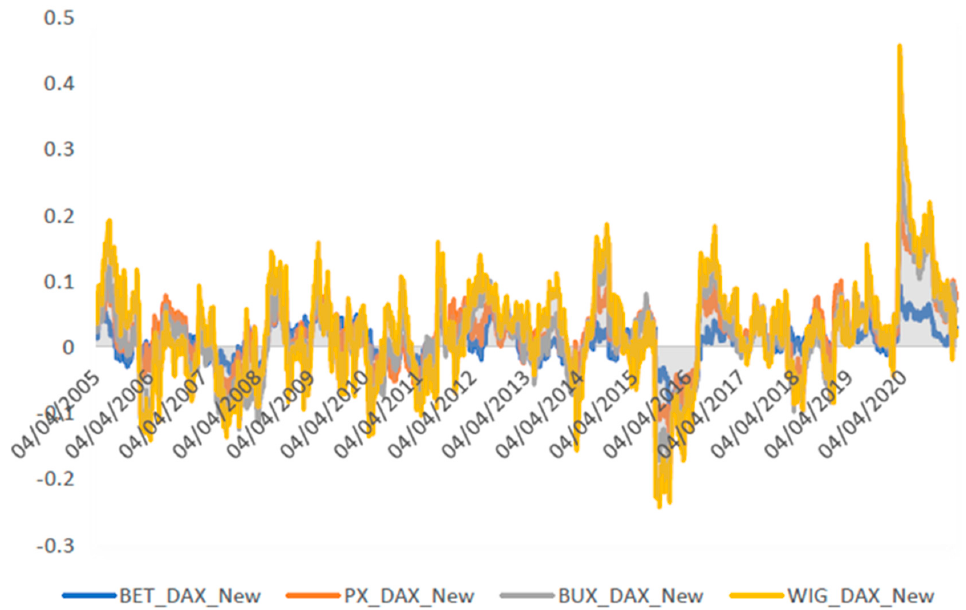
Figure 4. The evolution of the conditional correlation coefficients between the CEEC indices and the DAX index without any delay.